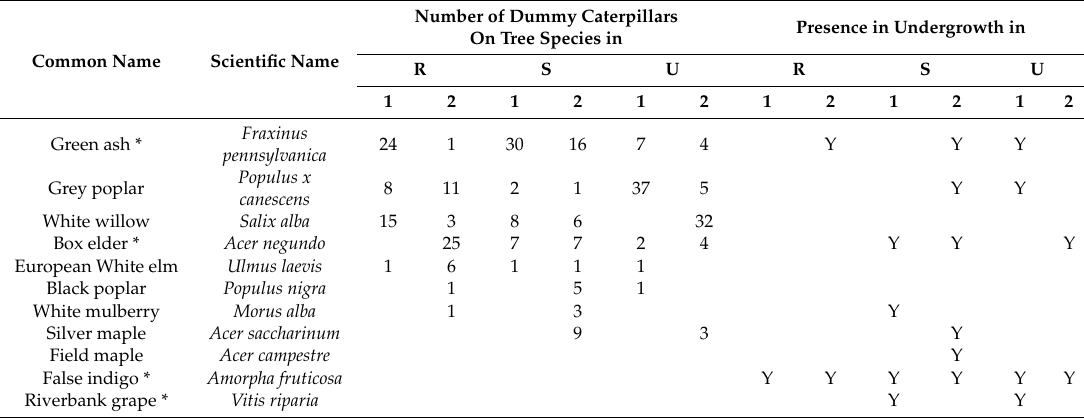
Table 1. Tree and shrub species presence and the number of dummy caterpillars placed per session at the observed habitats on tree trunks. R—rural, S—suburban, U—urban, Y—given species is present at the location.